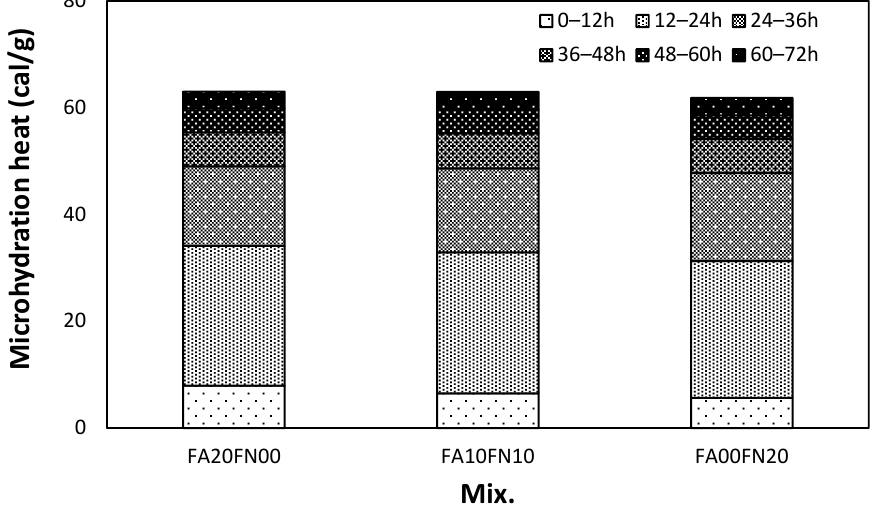
Figure 3. Microhydration heat.